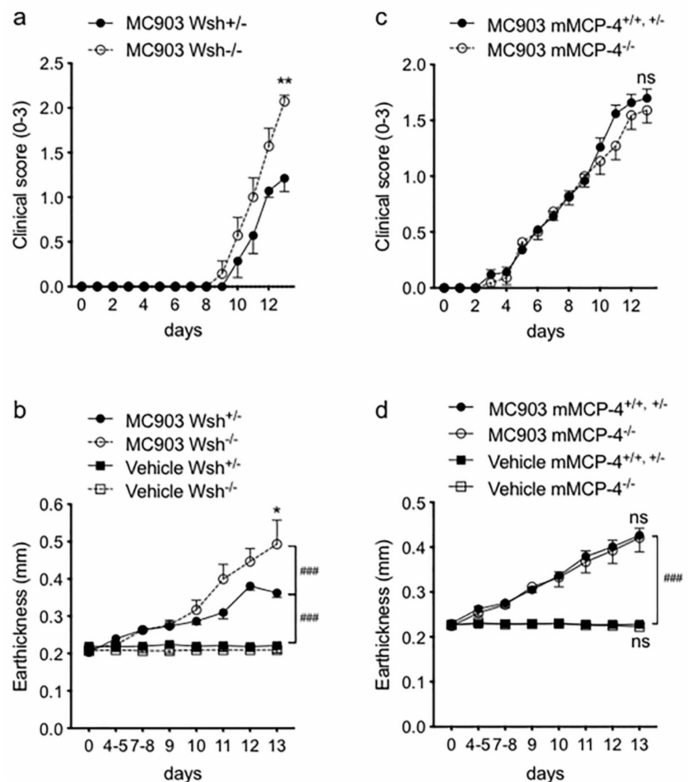
Figure 1. Mast cells a ff ect clinical symptoms in ear tissue after the MC903 application. Significant increase in clinical scores ( a ) and ear thickness ( b ) in c-kit-dependent mast cell-deficient W sh − / − mice compared to mast cell-competent W sh +/ − mice at day 14. In contrast, the mast cell-specific chymase mMCP-4 does not impact on the ( c ) clinical score and ( d ) ear thickness of MC903-induced atopic dermatitis. Age-matched 6–9 weeks old W sh +/ − ( n = 7) and W sh − / − ( n = 7) littermate and mMCP4 − / − ( n = 11) and mMCP4 +/ − , +/ − ( n = 25) littermate mice were used for the study. Statistical di ff erences in ( a , c ) were evaluated by two-way ANOVA with Sidak’s multiple comparison test. * p < 0.05, ** p < 0.01 Wsh − / − vs. Wsh +/ − (MC903-treated), ### p < 0.001 vs. vehicle-treated, ns, not